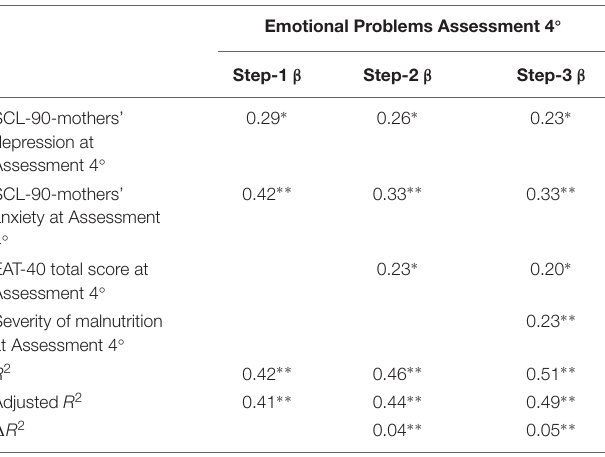
TABLE 7 | Hierarchical multiple regression models predicting emotional problems in children with Infantile Anorexia or ARFID subtype 1. Emotional Problems Assessment 4 ◦ Step-1